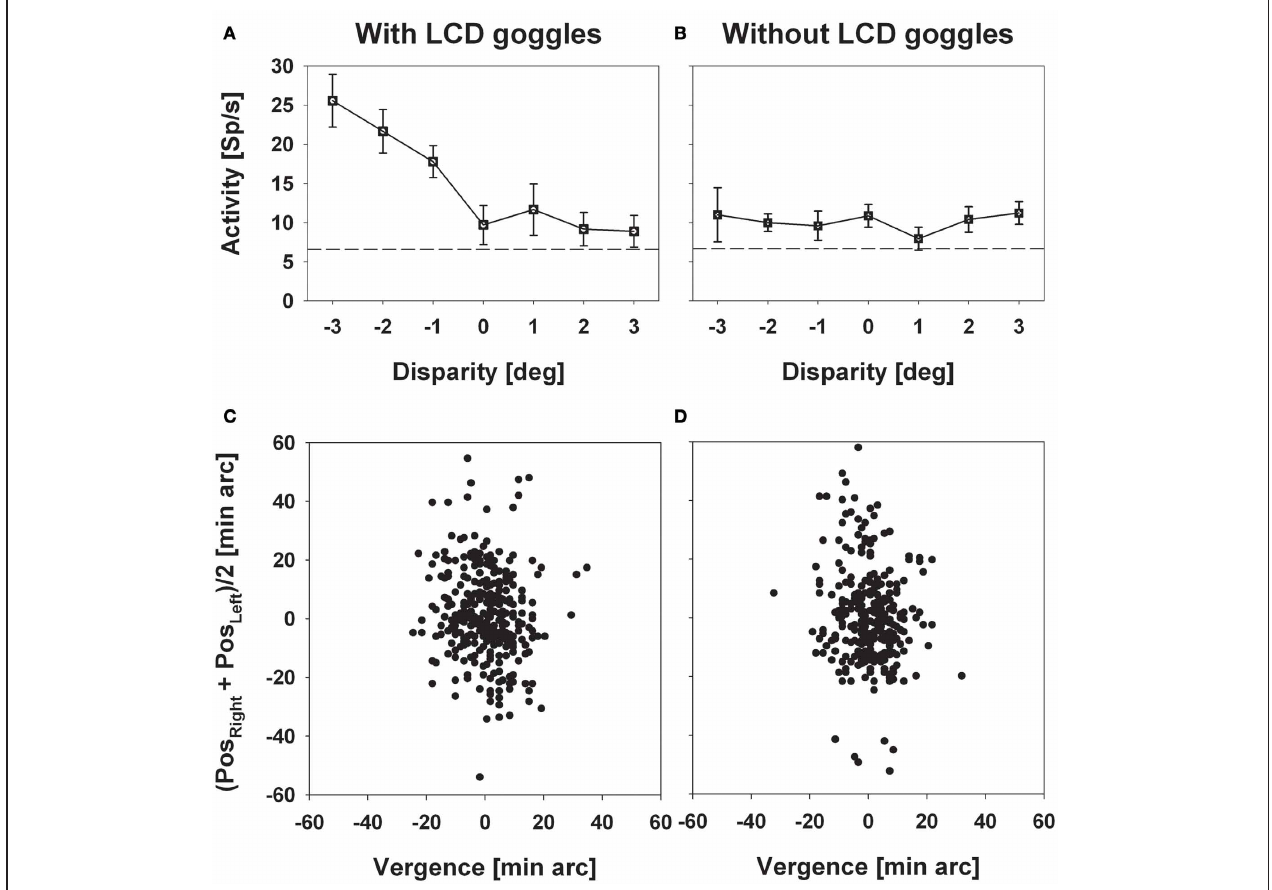
FIGURE 2 | Experimental validation of the stereoscopic setup. The left and the right column depict data obtained with (left) and without (right) the LCD goggles being synchronized with the stimulus computer. Panels in the upper row ( A and B ) show mean discharges ( ± standard error) of neural activity for stimuli presented at a certain disparity (depth, only perceivable with the goggles being synchronized).